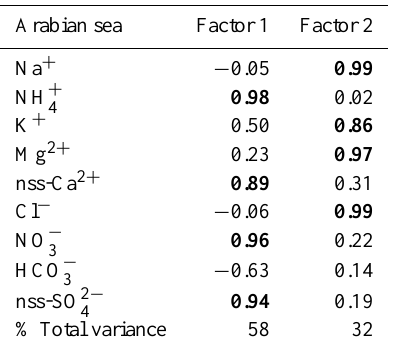
Table 7. Factor loadings and total variance identified in the Ara- bian Sea data set. ∗ Bold font indicates that the factor loading is significant at 95%